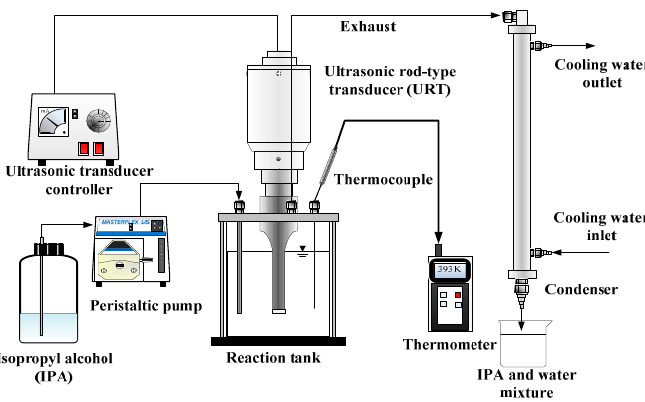
Figure 5. Schematic diagram of ultrasonic irradiation (UI) system.